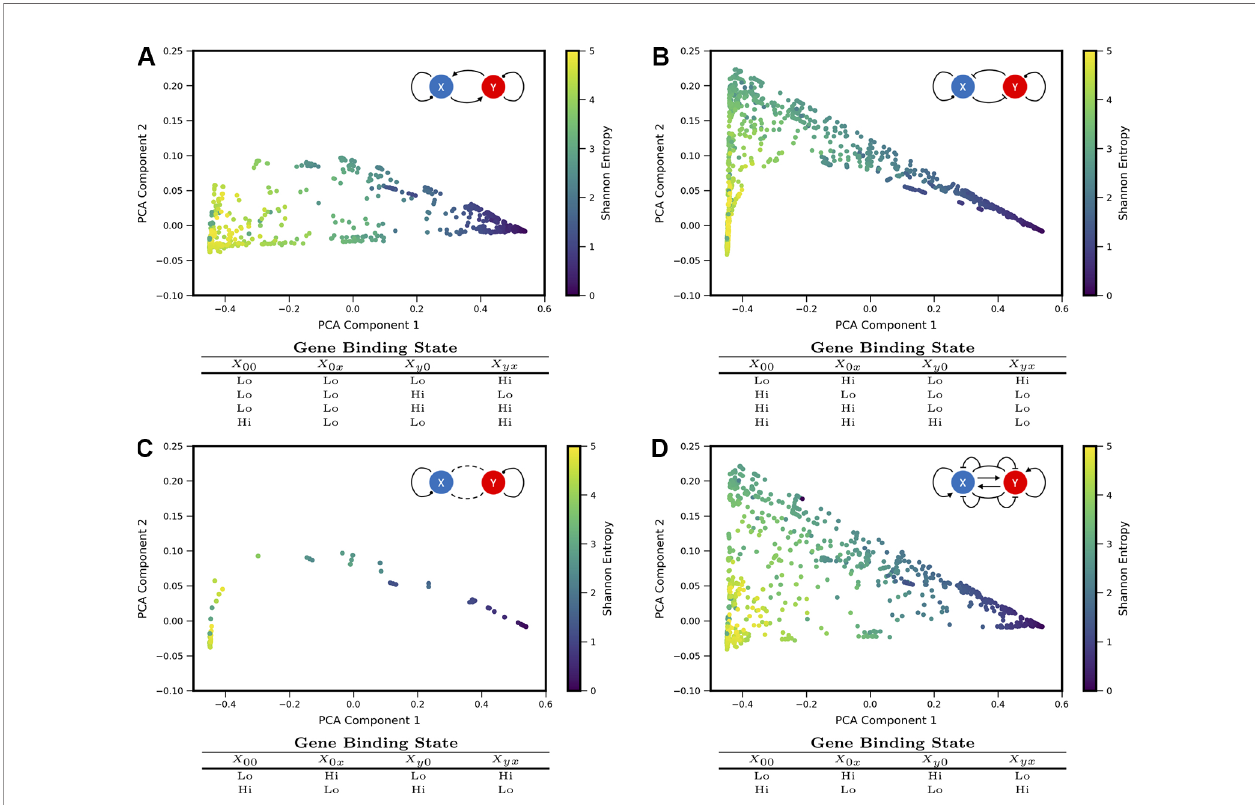
FIGURE 3 | Coexpression landscapes computed from the Two-Gene Flex models show distinctive shapes that depend on the regulatory logic of gene-gene interactions. The Two-Gene Flex model encodes 16 logical combinations (2 4 ) of gene-gene interactions, corresponding to four possible promoter-binding states and two possible levels of transcription activity (low and high). These 16 model variants can be grouped into motif classes: (A) Models with mutual activation. (B) Models with mutual repression. (C) No mutual gene-gene interactions. (D) “ Incoherent ” models, where the combinatorial-binding state has the opposite behavior of both of the singly bound states (see text). Within each motif class, different kinetic parameters serve to modify the relative strength of interactions (i.e., different weights on the edges). Each motif class occupies a distinct, but overlapping, region of the shape-space (with the exception of the Incoherent motif, which can reach all areas of the